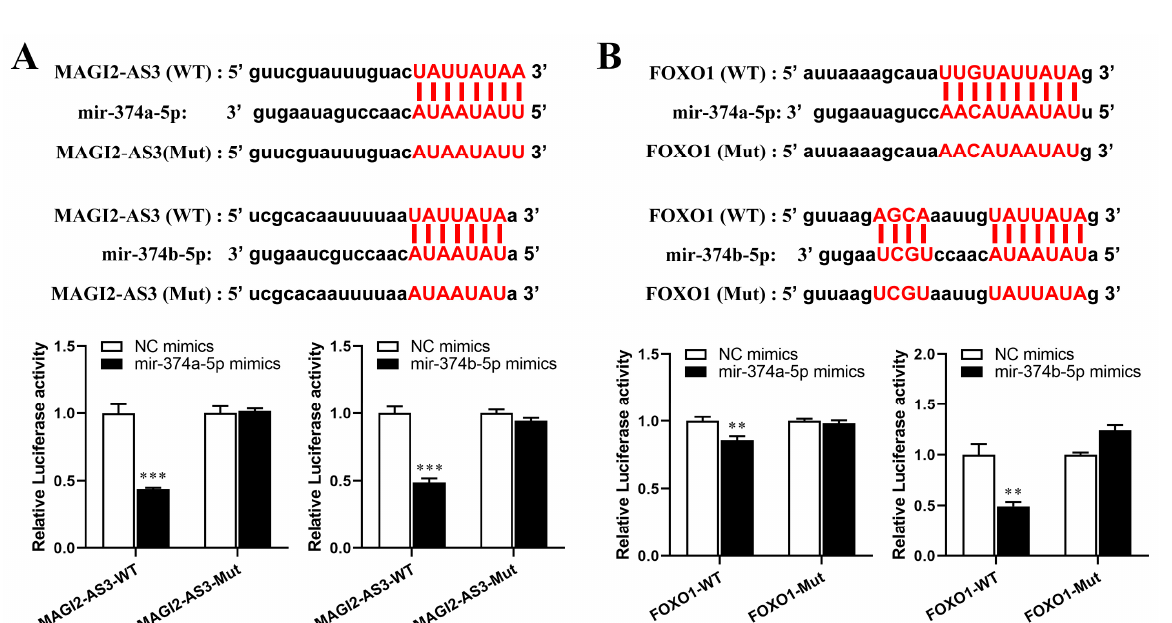
Figure 6. CeRNA network by HCC tissue sequencing predicted by qRT-PCR. The red circle represents upregulated miRNAs detected with p -value < 0.05 and verified, green square represents downregulated mRNAs detected with p -value < 0.05 and verified, green hexagon represents downregulated lncRNAs detected with p -value < 0.05 and verified. Blank square represents downregulated mRNAs detected with p -value < 0.05 but verified with p -value > 0.05. Relative expression levels of lncRNAs, miRNAs, and mRNA verified by qRT-PCR are shown on the left and right sides. HCC, hepatocellular carcinoma.